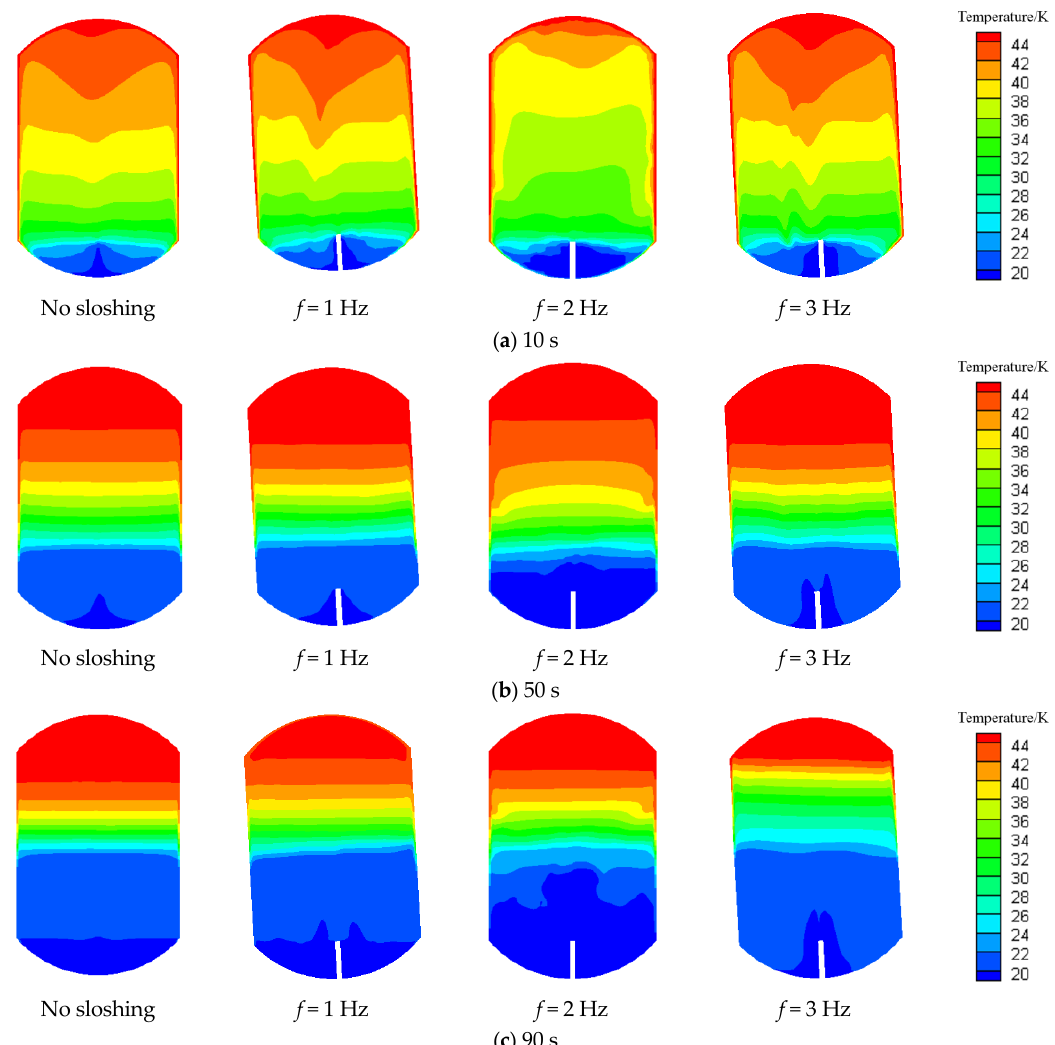
Figure 12. Graphic contours of temperature distribution under different sloshing frequencies ( A = 0.03 m) at ( a ) 10 s, ( b ) 50 s, and ( c ) 90 s.